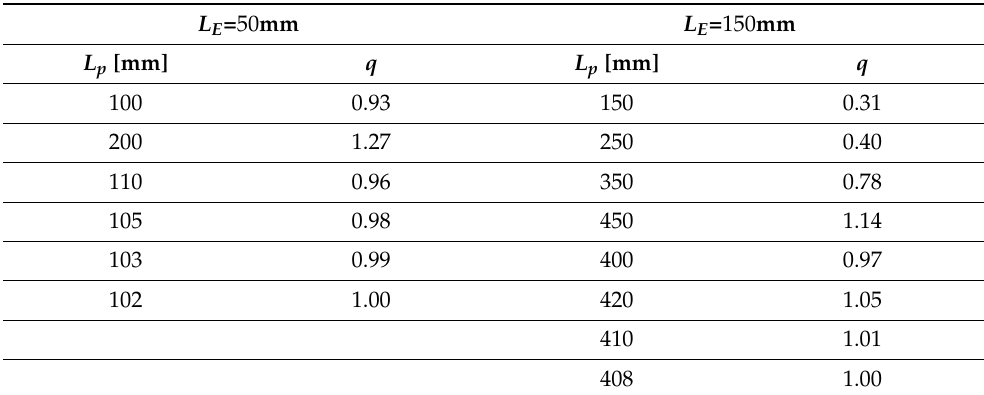
Table 3. Comparison of values of the spectra matching factor q for statistical evaluation of iterative determination of the polarization range L p of reinforcement in concrete at the shorter counter electrode L E = 50 mm and the longer counter electrode L E = 150